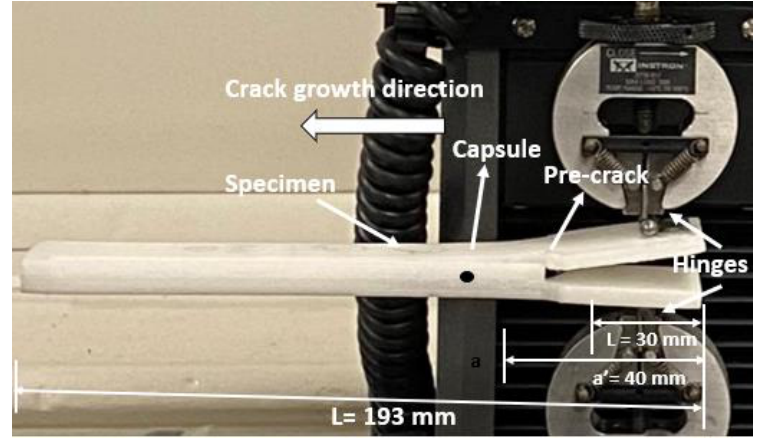
Figure 9. Double cantilever beam (DCB) test setup and showing pre-crack.